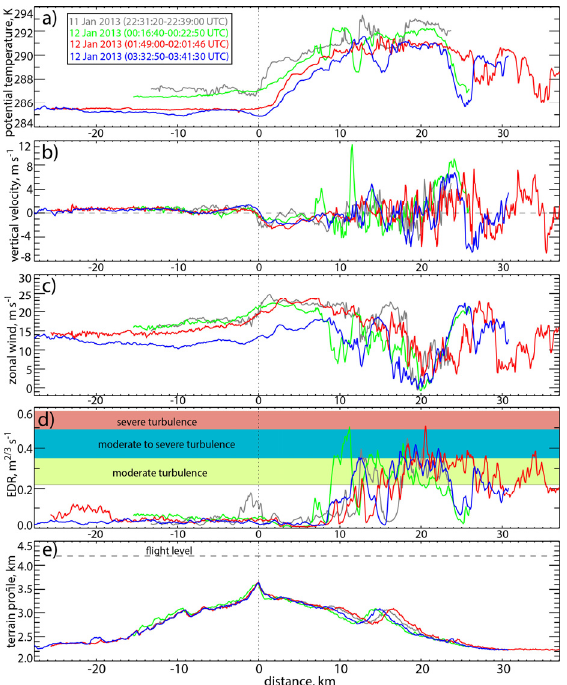
Figure 9. Flight-level atmospheric variables for the same four along-wind flight tracks shown in Figure 8. The vertical dotted line in all panels (x = 0) corresponds with the crest of the MBM. ( a ) Potential temperature; ( b ) vertical air velocity (the dashed line represents 0 m s − 1 ); ( c ) zonal wind; ( d ) eddy dissipation rate (EDR) measured by the MacCready turbulence meter, with colored layers indicating turbulence severity based on the classification of Strauss et al. [23]; and ( e ) underlying terrain profile (the dashed line in ( e ) represents the flight level).